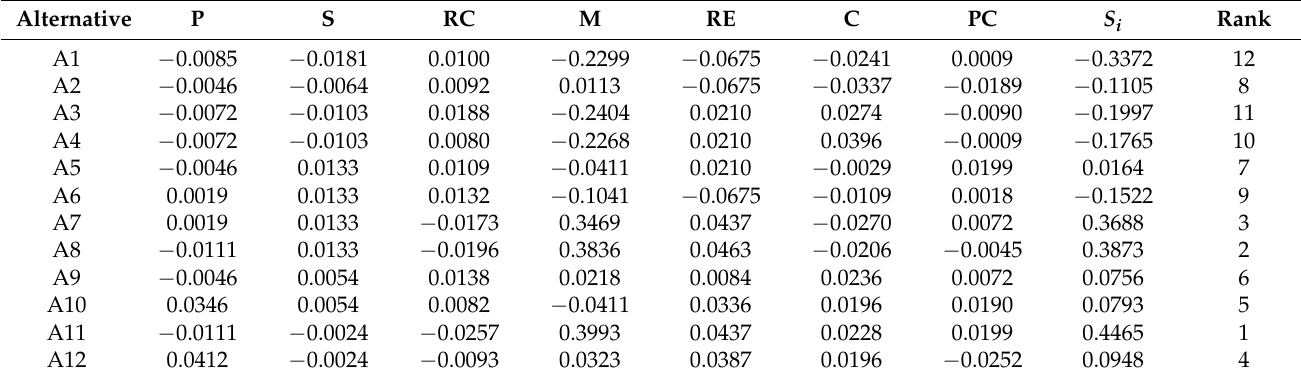
Table 11. Q matrix and ranks using MABAC.